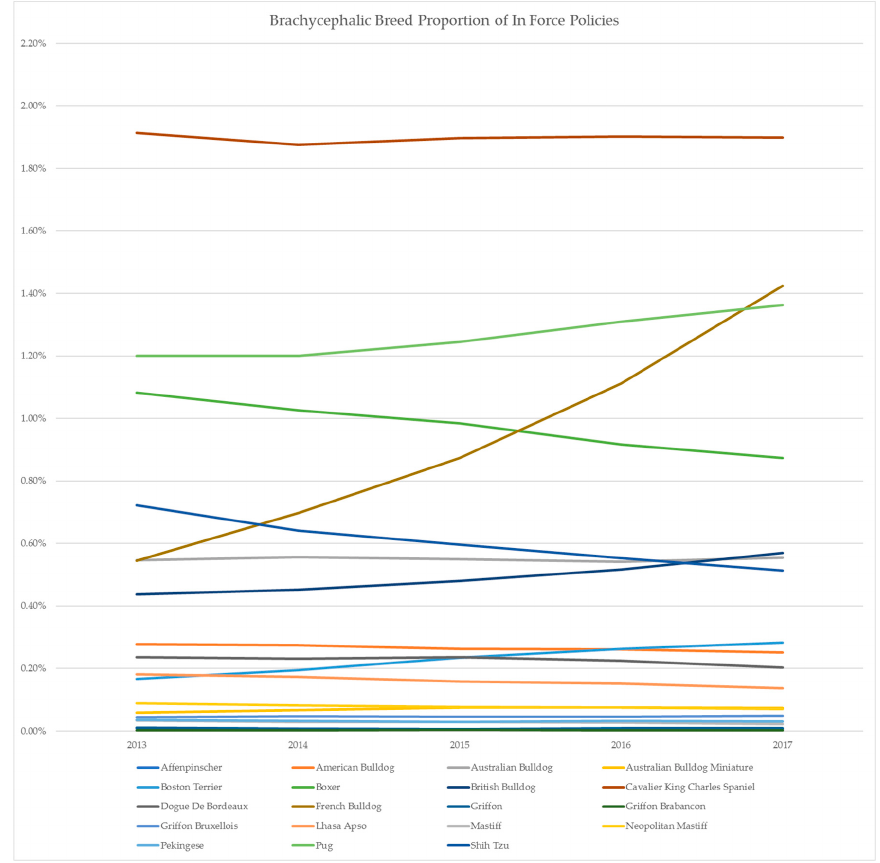
Figure 1. Distribution of PetSure insurance policies in force (2013–2017) for Boxers, British Bulldogs, French Bulldogs and